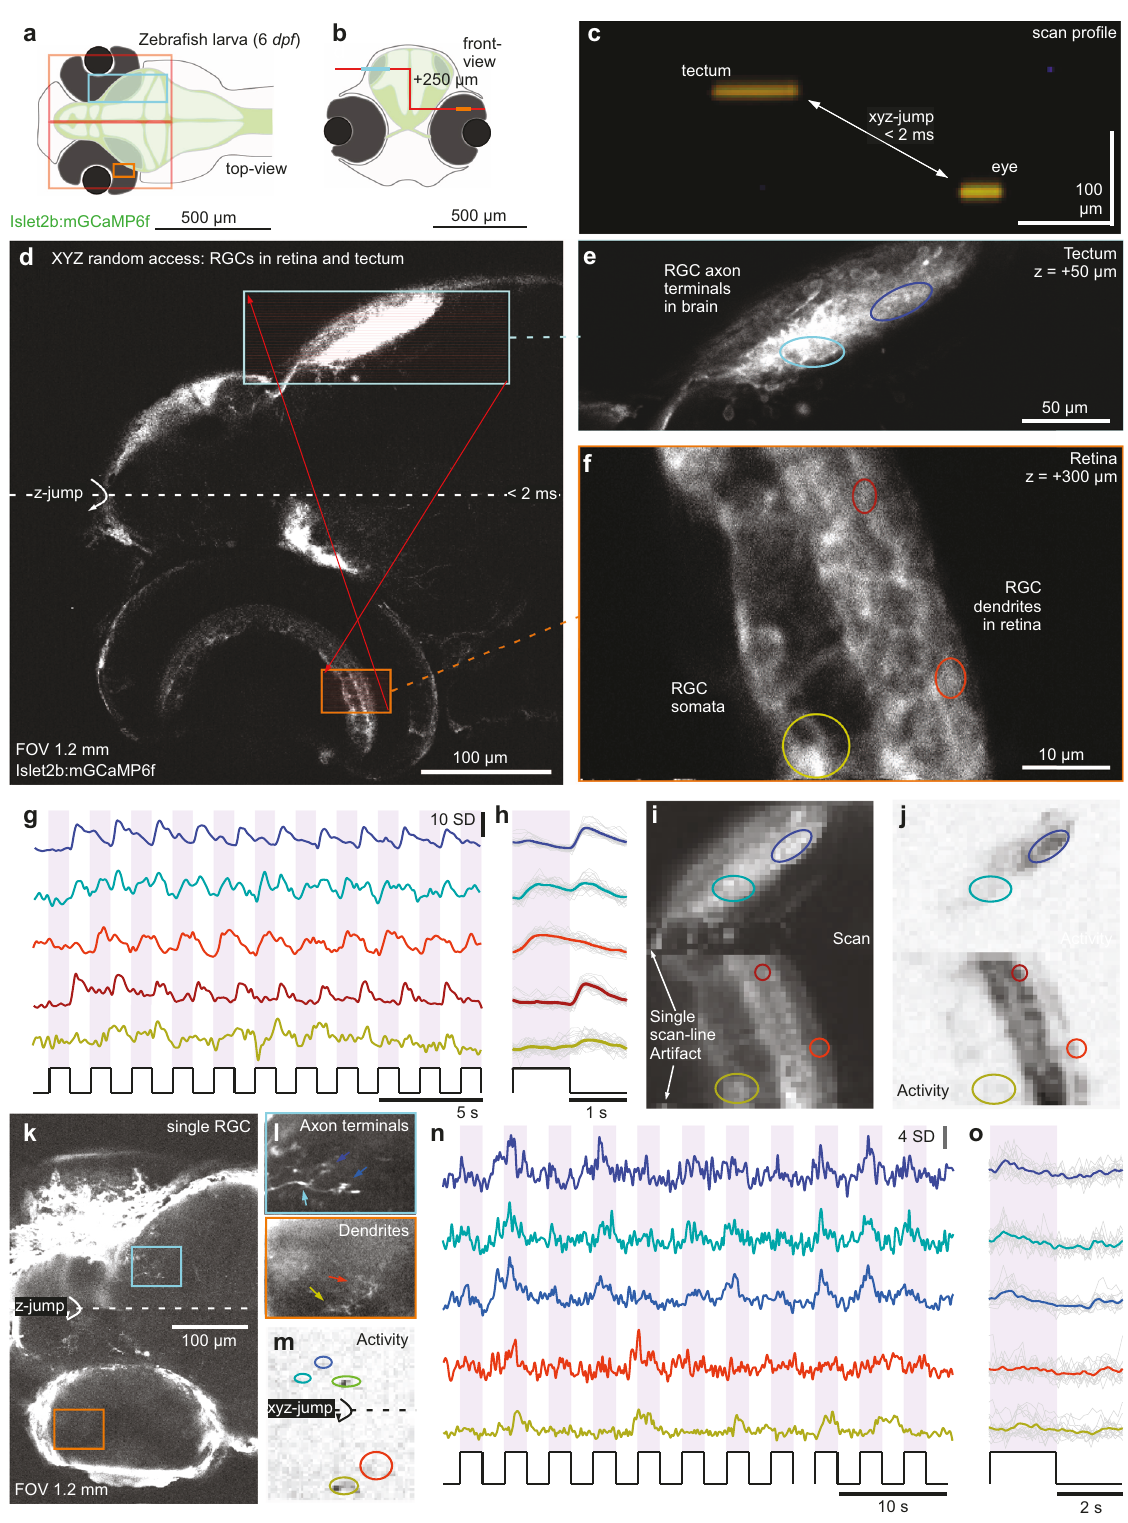
Fig. 6 3D random access scanning of the zebra fi sh eye and brain. a , b Schematic of zebra fi sh larva from top ( a ) and front ( b ) with scan con fi gurations indicated. c direct x-z visualisation of the scan-pro fi le used in the below. d nTC 1 1024 × 1024 px scan across an Islet2b:mGCaMP6f 6 dpf larval zebra fi sh eye and brain. At the centre of the scan, the axial focus is shifted upwards such that the axonal processes of retinal ganglion cells (RGCs) in the tectum (top) and their somata and dendritic processes in the eye (bottom) can be quasi-simultaneously captured. e , f , 1024 × 1024 px split-plane random access jump between tectum ( e ) and eye ( f ) and g – j 2 times 64 × 128 px (15.6 Hz) random access scan of the same scan regions with raw ( g ) and event-averaged ( h ) fl uorescence traces, mean image ( i ) and activity-correlation ( j , cf. Fig. 3c). The stimulus was a series of full- fi eld broadband fl ashes of light as indicated. k – o as ( d – j ), with individual RGCs transiently expressing GCaMP6f under the same